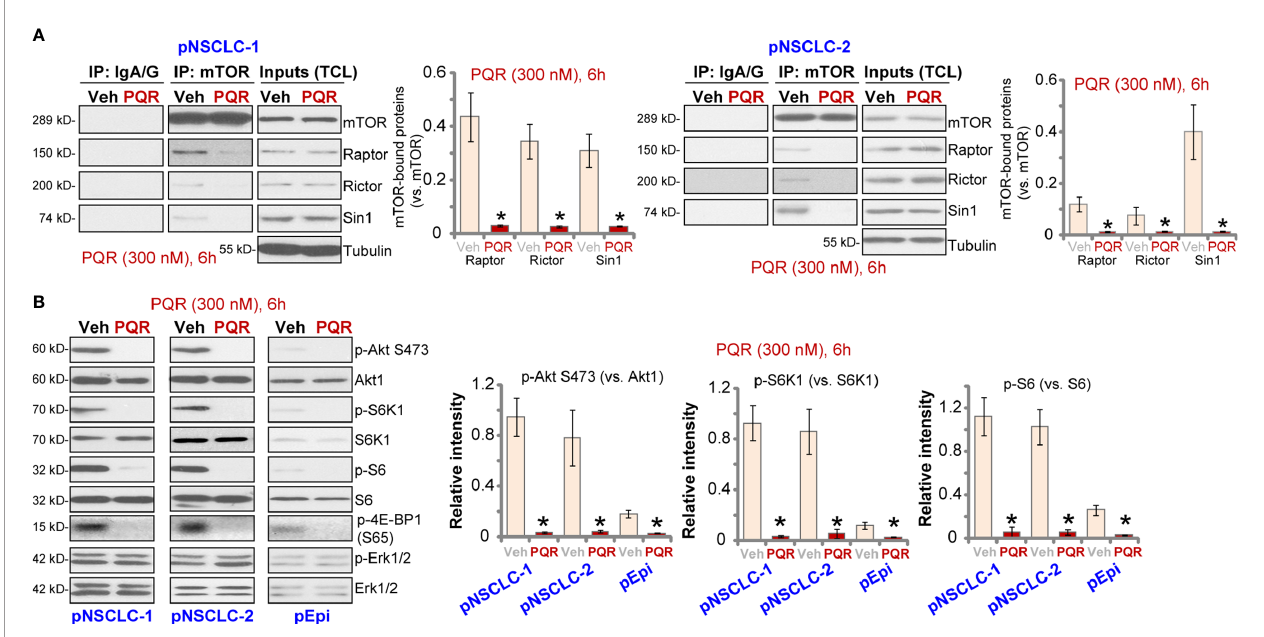
FIGURE 3 | PQR620 blocks mTOR activation in NSCLC cells. Primary NSCLC cells, pNSCLC-1/-2, or primary lung epithelial cells ( “ pEpi ” ) were treated with PQR620 (300 nM) or the vehicle control ( “ Veh ” ), cells were further cultured for 6 h, mTOR immunoprecipitation with Rictor, Raptor and Sin1 were tested by co- immunoprecipitation assays (A) Expression of listed proteins was tested by Western blotting analyses ( A : Inputs, and B ). Quanti fi cation of the listed proteins was through the ImageJ software. Data were presented as mean ± standard deviation (SD, n=5). * p < 0.05 vs. “ Veh ” cells. Experiments were repeated fi ve times with similar results